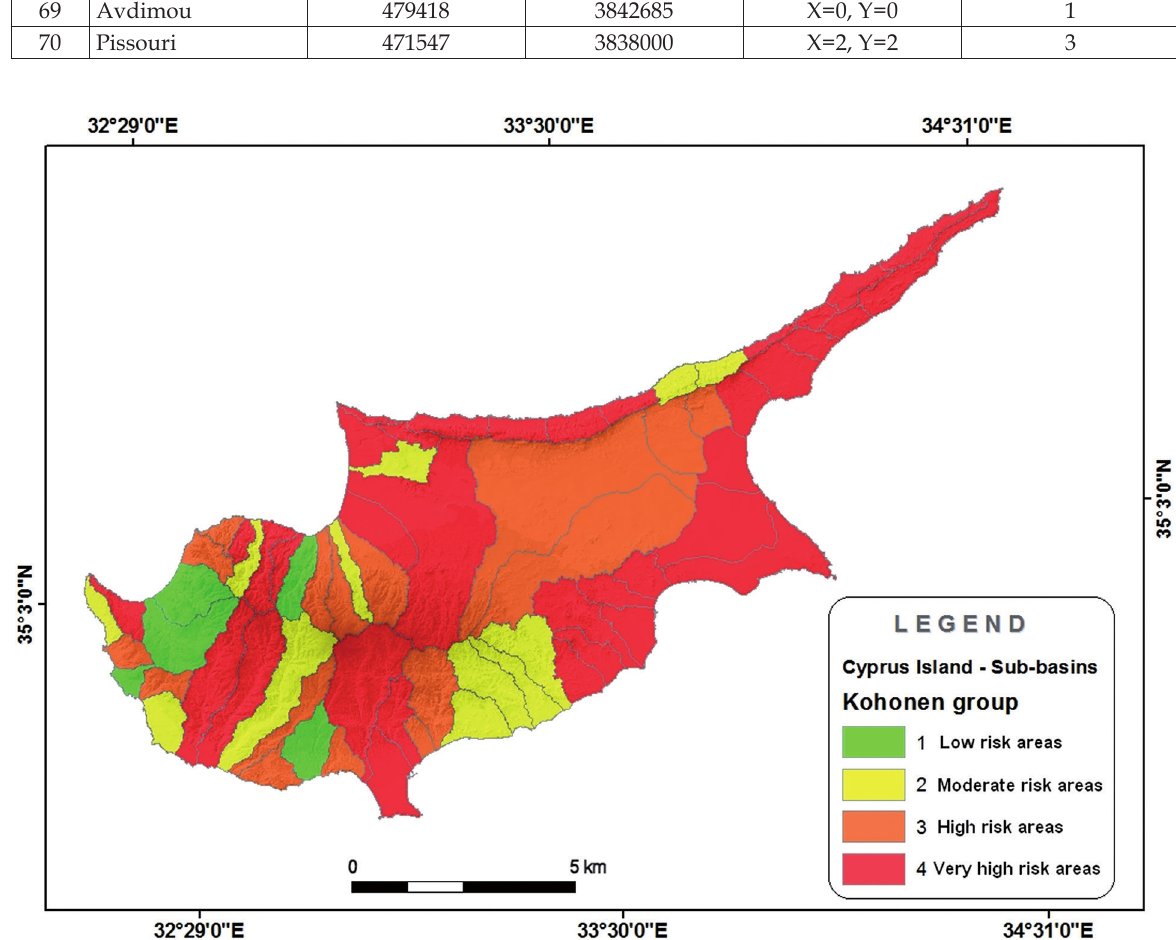
Fig. 3. Map of Cyprus with risk